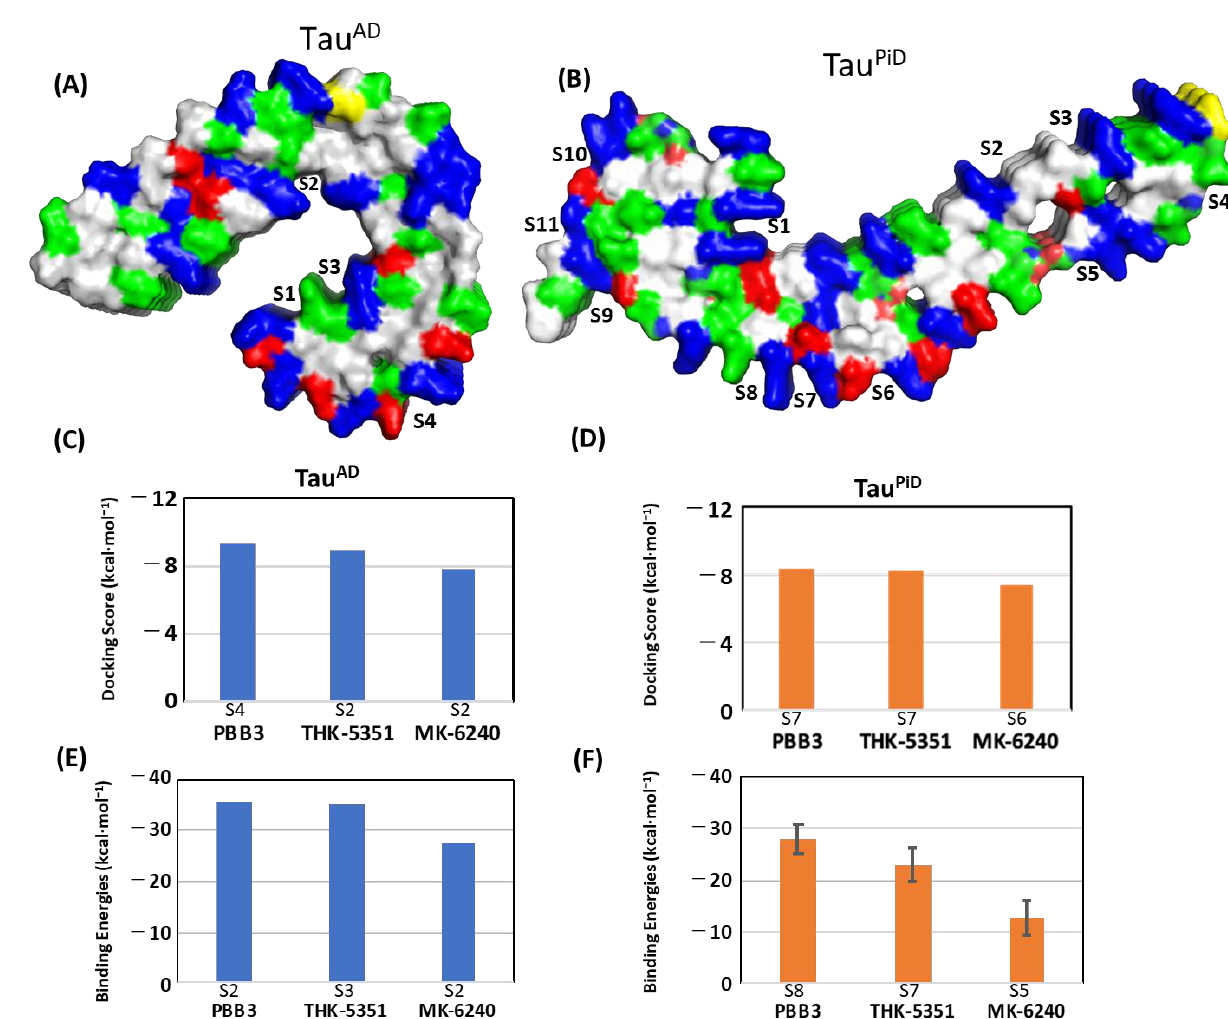
Figure 4. Comparison of the surface binding sites in Tau AD reported previously ( A ) and Tau PiD studied in this paper ( B ). Surface representation for tau structures is colored as residue type (acidic-red, basic-blue, nonpolar-grey, polar-green, cysteine-yellow). Docking scores of the strongest docking pose for PBB3, THK-5351 and MK-6240 in the best scoring site in Tau AD reported in Murugan et al. [25] ( C ) and Tau PiD ( D ). Similarity of MM/GBSA binding energy (kcal · mol − 1 ) of the strongest binding modes of PET probes in Tau AD ( E ) and Tau PiD ( F ).